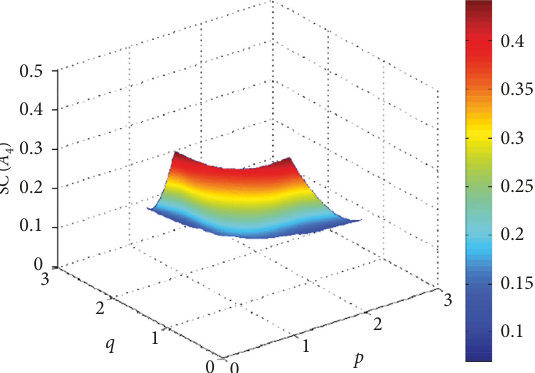
Figure 14: SC ( F ) of A based on the A-HF2TLWBM operator and the A-HF2TLWGBM 4 4